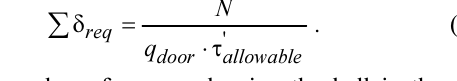
Intensity q , m/min.